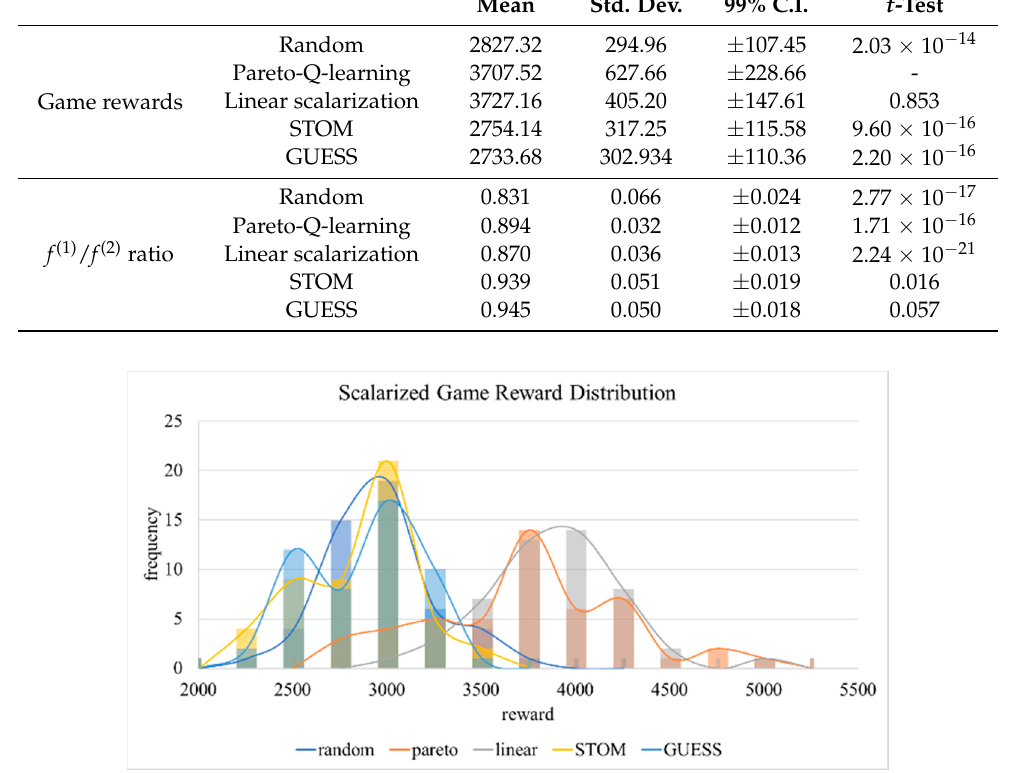
Figure 8. Distribution of f (1) / f (2) ratio. The results show that Pareto-Q-learning and linear scalarization consistently outperform the other approaches for the cumulative rewards. A standard t -test, with a p -value of 0.05, confirms this difference. Linear scalarization performs comparable to Pareto-Q-learning with a t-statistic of 0.853. STOM and GUESS perform very poorly with results comparable to a random strategy selection. If the defender aims to merely maximize the game rewards, regardless of which goals are prioritized, the Pareto-Q-learning approach or linear scalarization give the best results. The cosine results, however, show that Pareto-Q-learning and linear scalarization achieve this high cumulative result by ignoring the defender’s desired goal prioritization. The STOM and GUESS approaches meanwhile result in a goal distribution which is close to the optimum. The GUESS distribution is statistically not different from the desired goal prioritization. The standard t -test confirms this with GUESS t -statistic of 0.057, being the only one to exceed the p -value of 0.05. It is noteworthy that the STOM method led to a ratio that was still close to the desired goal prioritization, while the other approaches were nowhere near the distribution. The results clearly show that if the defender wishes to have control over goal prioritization, the GUESS approach is the best. However the fairer distribution of rewards may not be worth the loss in